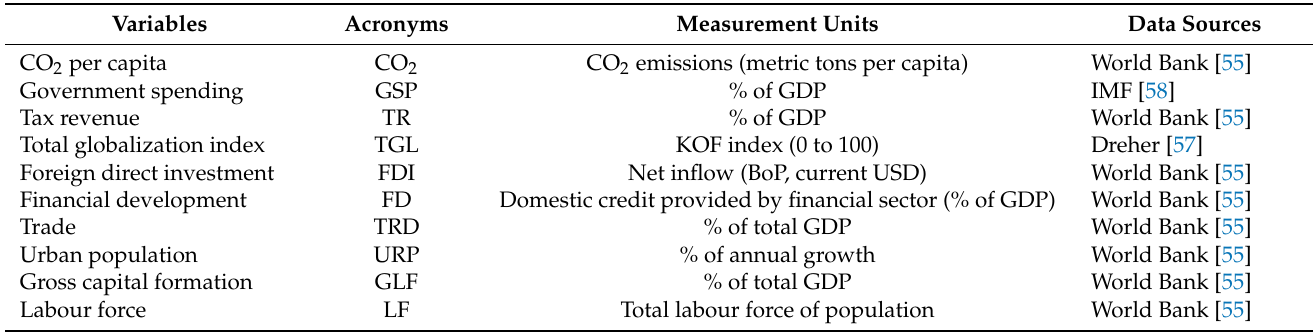
Table 1. Measurement units of variables, acronyms, and data sources.